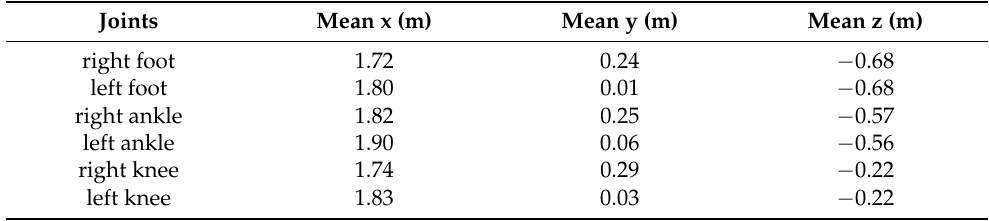
Neko Aishi Dachi